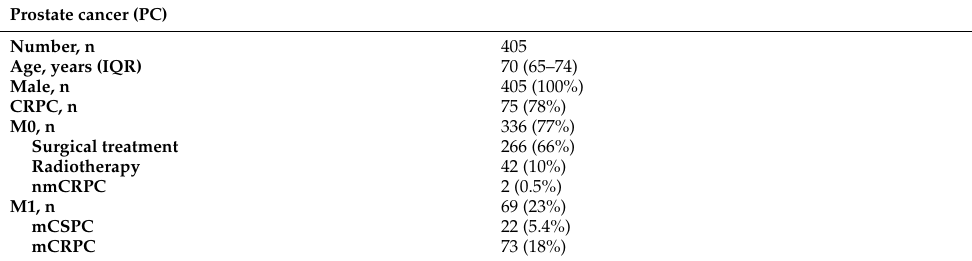
Table 3. Detailed information of patients with urological cancers.